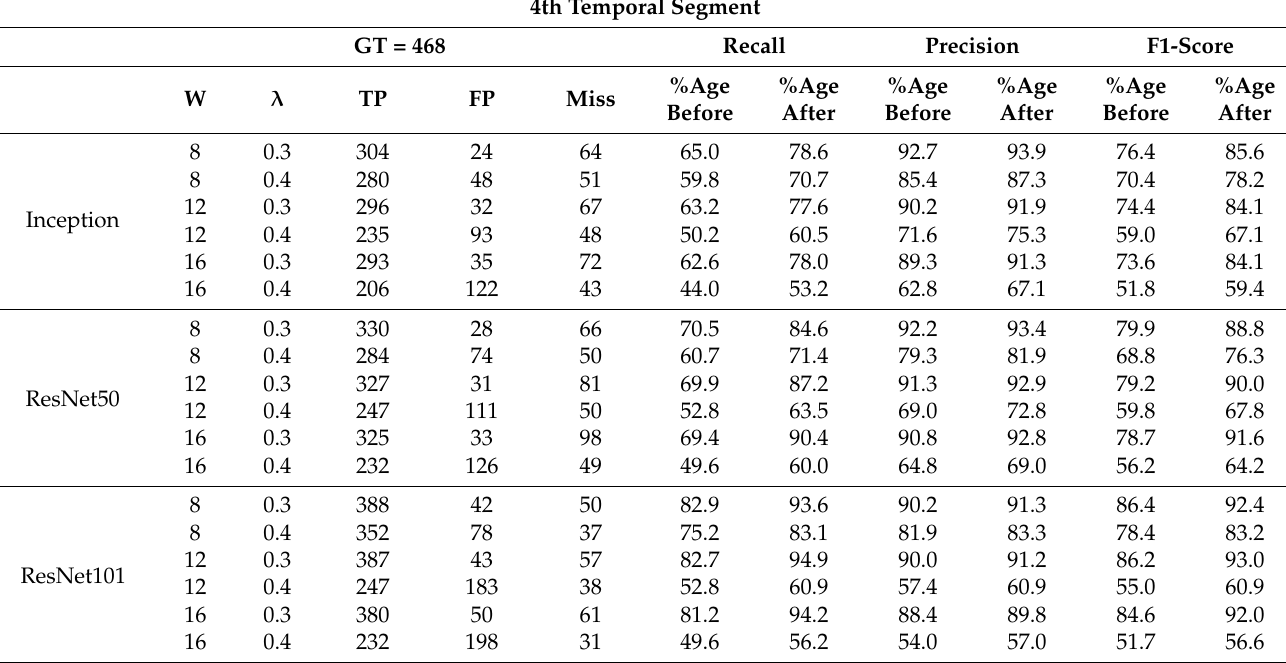
Table A5. Detections and refinement results of 4th temporal segment.